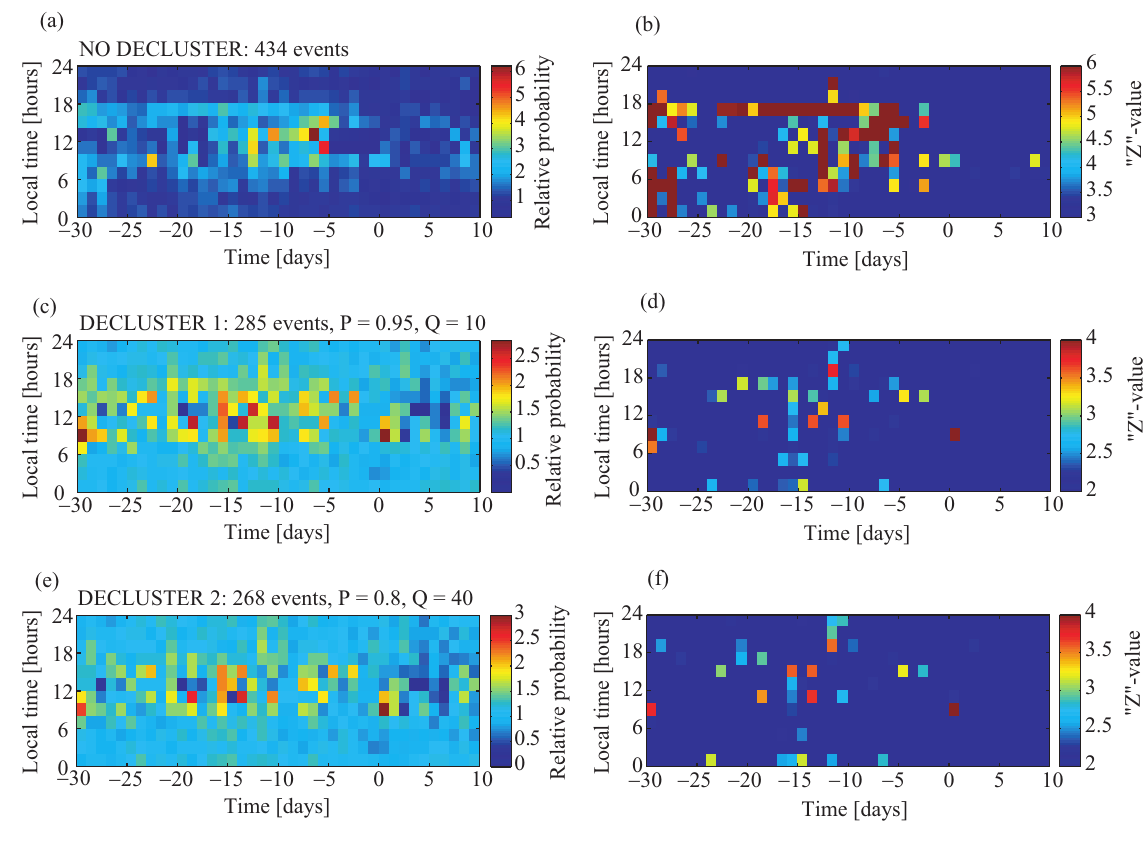
Fig. 5. Effect of declustering on significance. (a) No declustering (same as Fig. 4a), (b) significance of (a) (same as Fig. 4d), (c) typical declustering level, and (d) significance of (c), (e) aggressive declustering and (f) significance of (e).